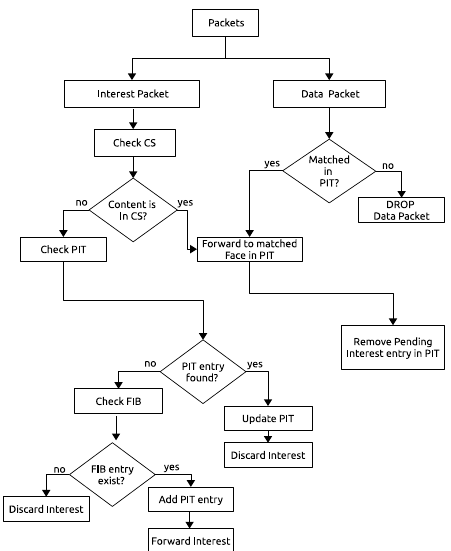
Figure 4. Single interest/data packet forwarding